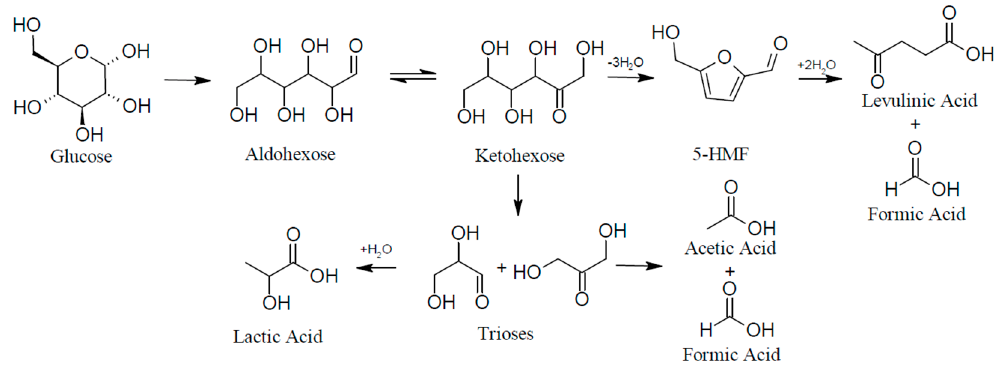
Figure 1. Reaction pathway for hexoses using Sn-Beta.